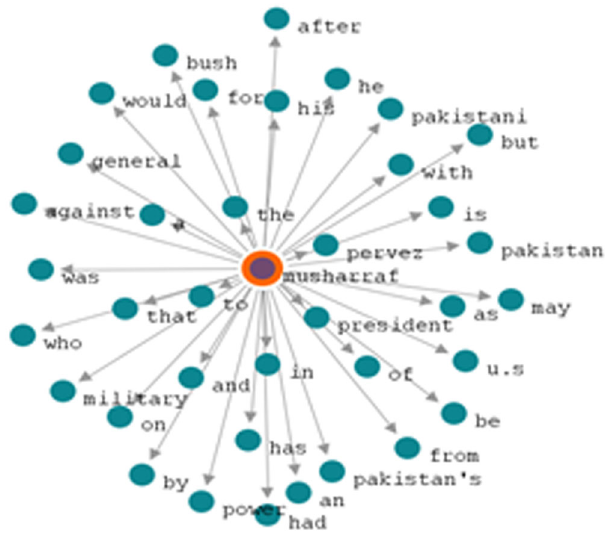
Fig. 2 Collocation result. Collocation network of Musharraf* (using